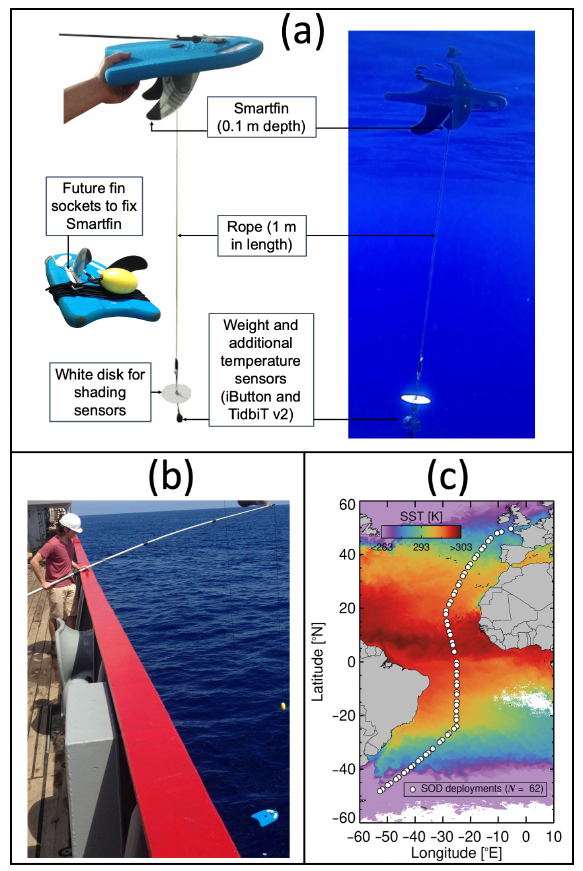
Figure 1. Experimental set-up and station locations. ( a ) The Simple Oceanographic floating Device (SOD) with Smartfin integrated, 1m rope with iButton and TidbiT v2 sensors and white disk. Underwater image of the SOD at a station in the North Atlantic. ( b ) At stations where the currents were pushing the SOD into the side of the RRS James Clark Ross, a telescopic rod was used to extend the rope further away from the ship. ( c ) Location of SOD deployments on AMT28, overlain onto a SST4 monthly composite of October 2018 from the MODIS-Aqua satellite